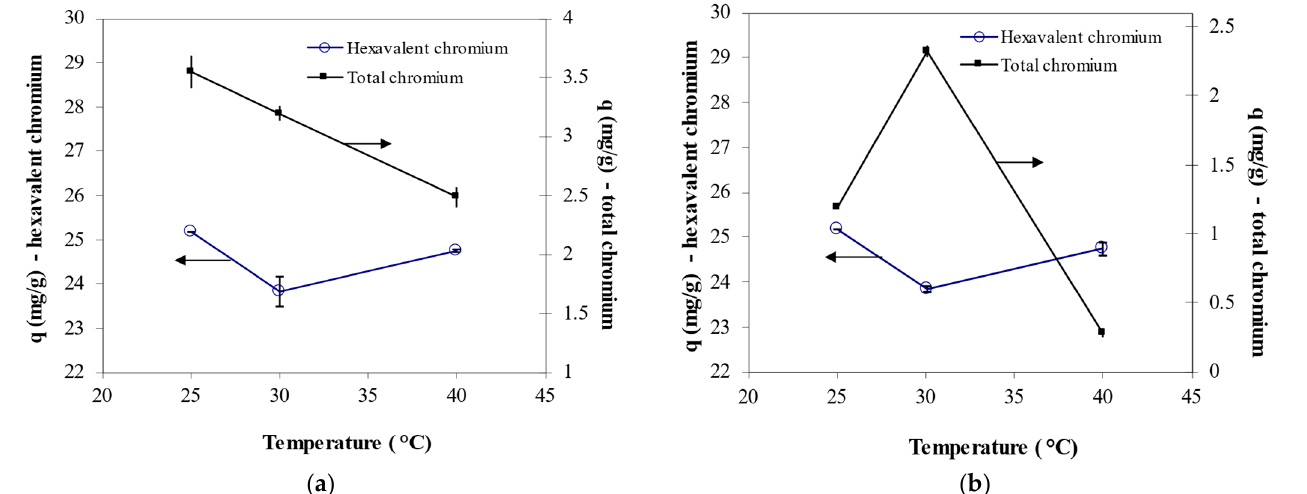
Figure 6. Effect of temperature on Cr 6+ and total chromium biosorption efficiency and metal uptake capacity by ( a ) B. megaterium and ( b ) Rhodotorula sp. inactive biomass (pH = 1, biosorbent dose = 8 g/L, contact time = 48 h, initial concentration = 201.90 mg/L).